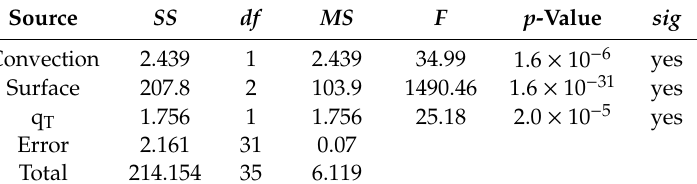
Table 12. Results of ANOVA for radiative heat transfer coefficient.